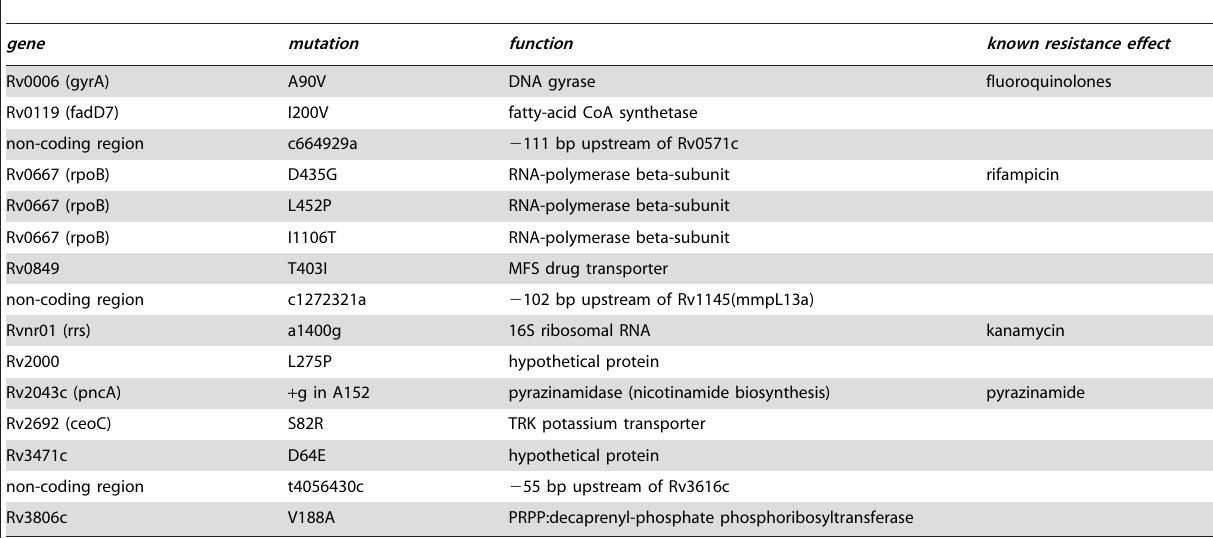
This table excludes synonymous mutations in coding regions, and mutations in PPE/PGRS genes or repetitive sequences. Mutations in coding regions are numbered as amino acids substitution (upper case). Numbering of base substitutions (lower case) in non-coding regions is given relative to the H37Rv genome.